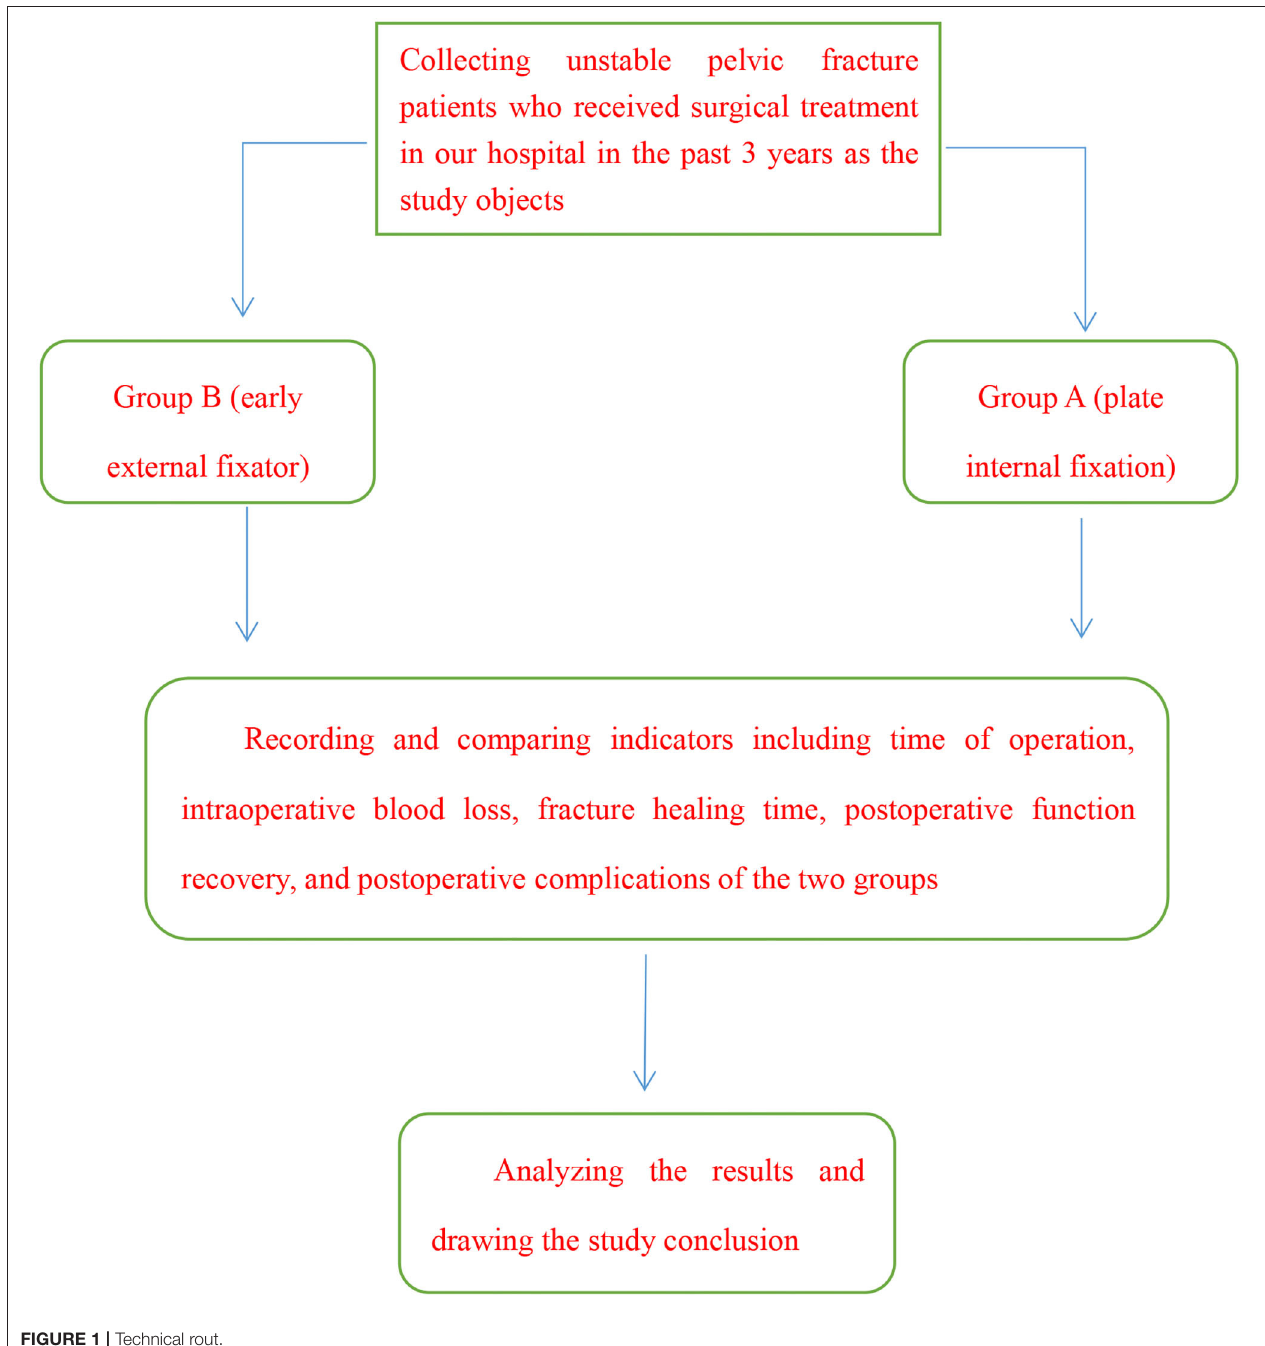
FIGURE 1 | Technical